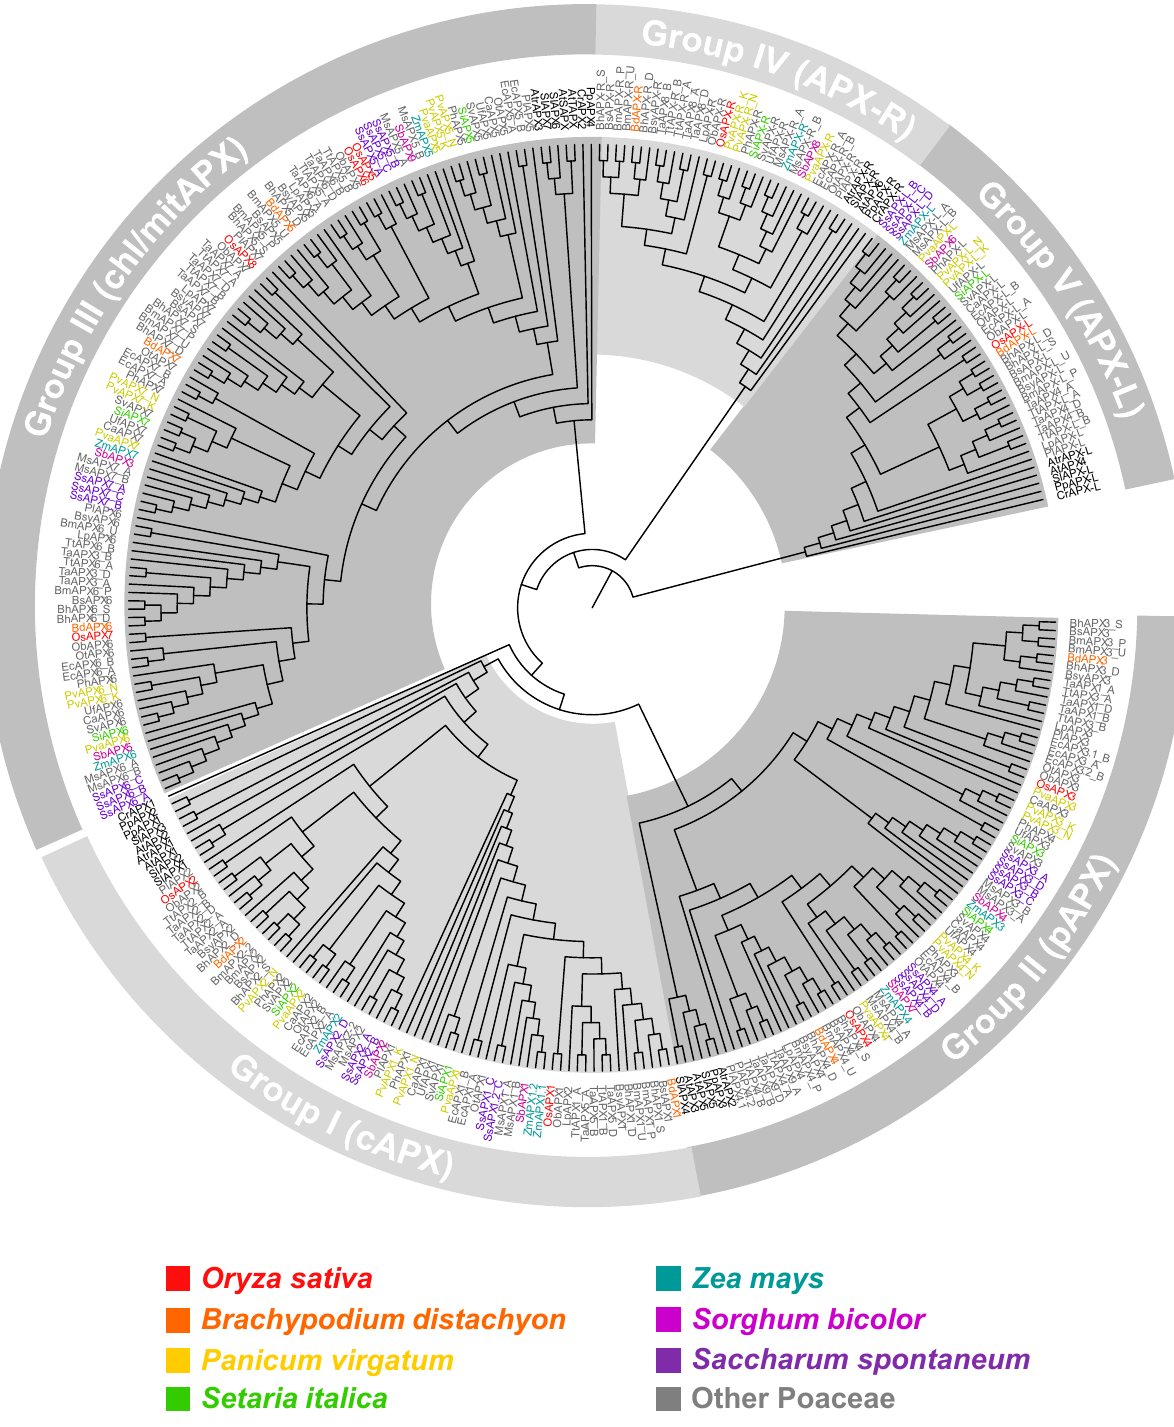
Figure 1 – Phylogenetic analysis of APX, APX-R and APX-L proteins. The phylogenetic relationship between APX, APX-R, APX-L was reconstructed using the maximal-likelihood method under the best model selection in IQ-TREE software with 1000 replicates of rapid bootstrap and aLRT statistics. A total of 334 protein sequences were included in the analysis, and ambiguous positions were removed from the alignment. The protein sequences separated in five well-supported clusters: Group I – cytosolic APX (cAPX); Group II – peroxisomal APX (pAPX); Group IIII –